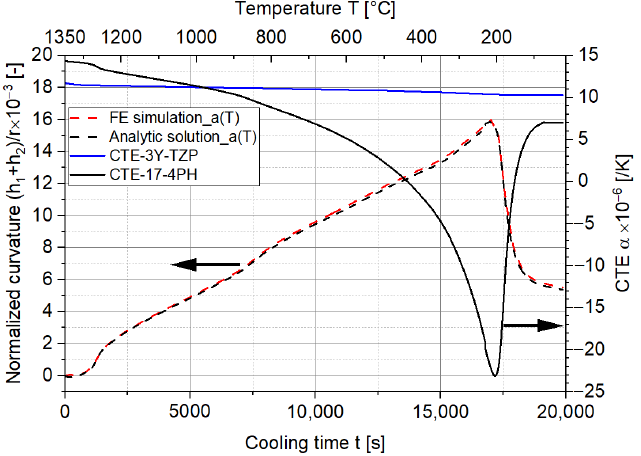
Figure 10. Comparison of the normalized curvatures between the analytic solution and FE simulation after consideration of the CTE during the cooling down process.